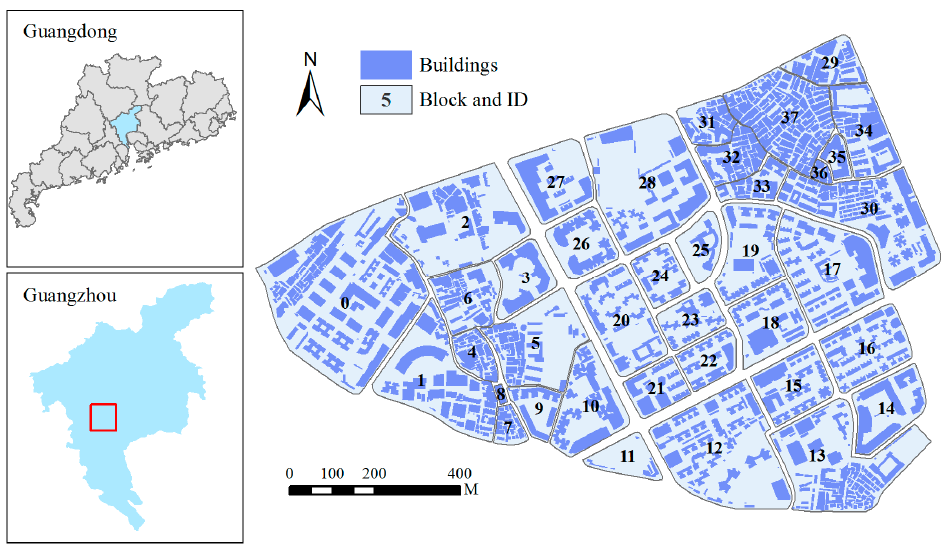
Figure 4. Study area in the city of Guangzhou and a 1:2000 building and road network dataset.